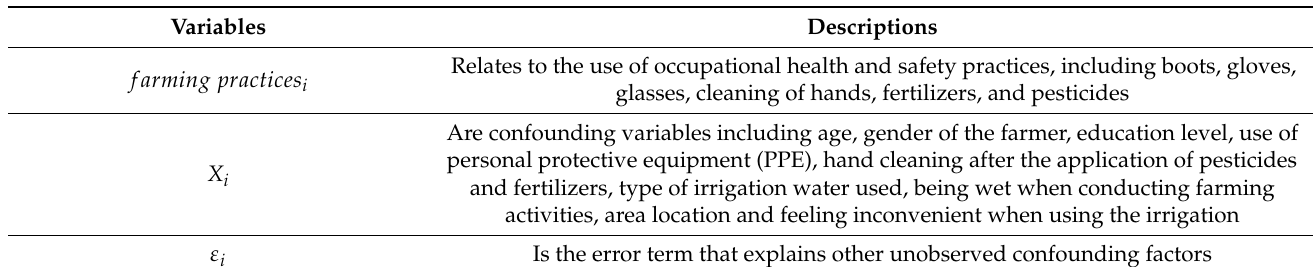
Table A3. Description of variables used in the second